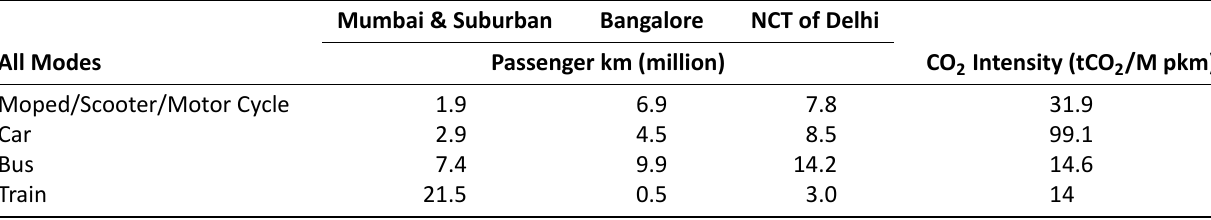
intensity in Mumbai, Bangalore and 2